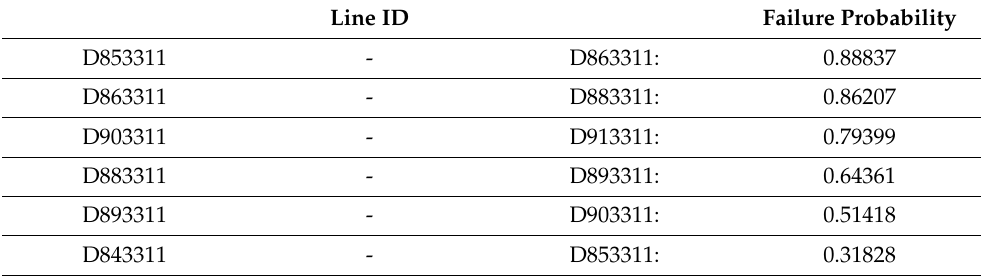
Table 8. List of critical components with their failure probabilities over 10 min, case